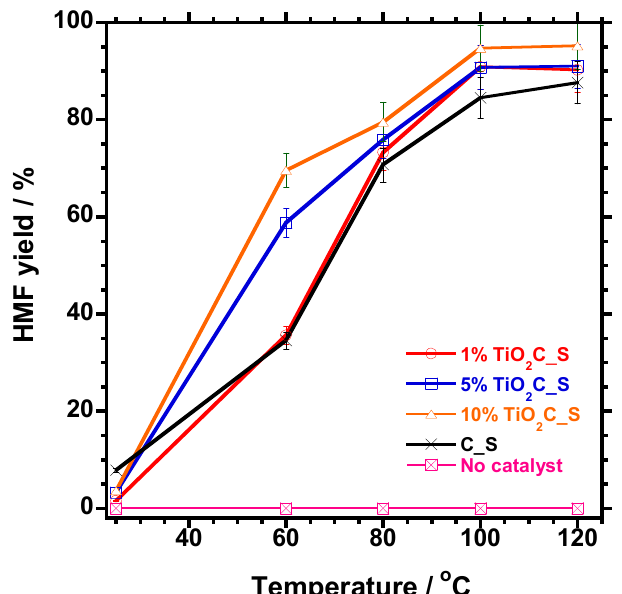
Figure 6. Effect of reaction temperature on fructose dehydration into HMF using sulfonated carbon and TiO 2 C composite catalysts in DMSO solvent.